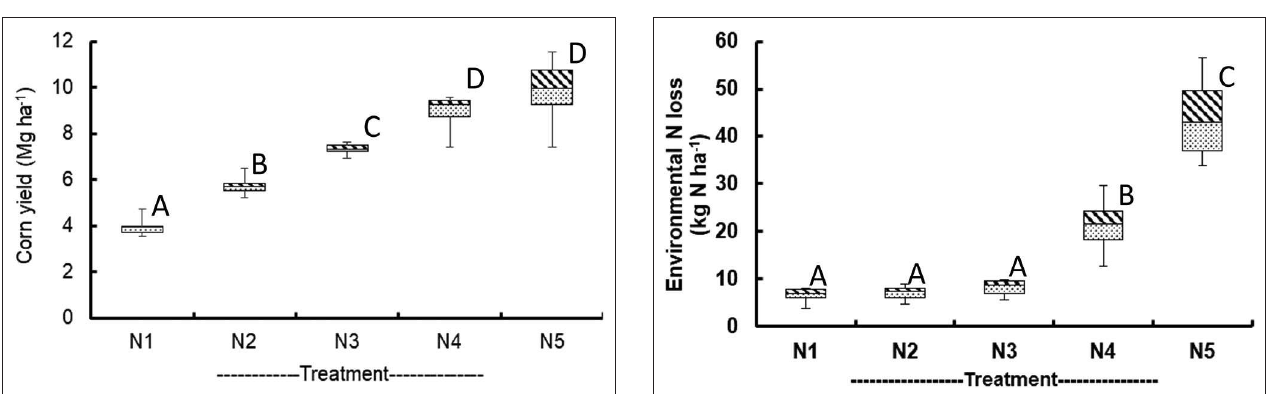
FIGURE 2 | DNDC estimated environmental nitrogen loss (kg N ha − 1 ) from corn production. In the treatments, 30kg N ha − 1 was applied at planting and rest was sidedressed in the growing season. Total N rates in five treatments were as follows: N1: 30kg N ha − 1 ; N2: 57kg N ha − 1 ; N3: 87kg N ha − 1 ; N4: 145kg N ha − 1 ; N5: 218kg N ha − 1 . Treatments indicated by letters are significantly different from each other with a p -value of 0.05 based on a Tukey HSD (Honestly Significant